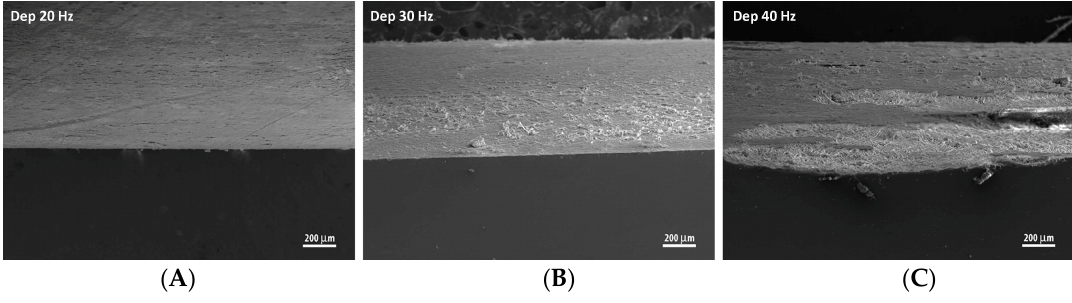
Figure 7. SEM images of the edge of the samples formed at ( A ) 20 Hz; ( B ) 30 Hz; ( C ) 40 Hz.